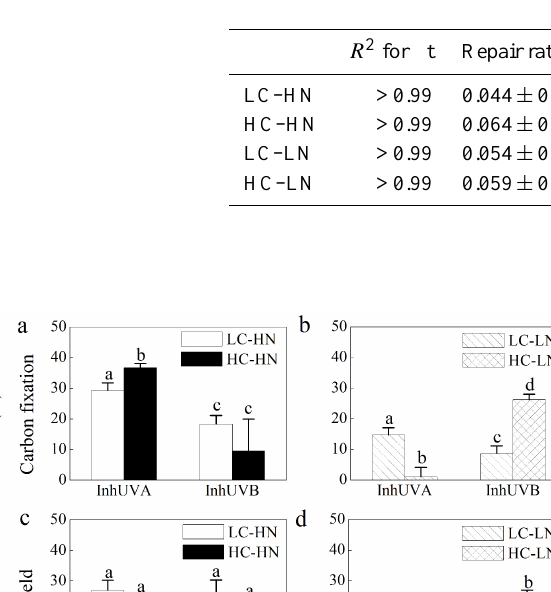
Table 2. The PSII damage ( k ) and repair ( r ) rate constants (min − 1 ) in Phaeodactylum tricornutum cells grown in LC–HN, LC–LN, HC–HN and HC–LN during the 60 min exposures to PAR + UVA + UVB (44 . 11 + 14 . 19 + 0 . 75Wm − 2 ) . Parameters of repair and damage rates were calculated based on Fig. 2 according to Heraud and Beardall (2000). SD was for triplicate cultures. Treatments with the same lowercase superscript letters mean the difference is not significant. In contrast, treatments with different lowercase superscript letters indicate the difference is significant ( P< 0 . 05 level).